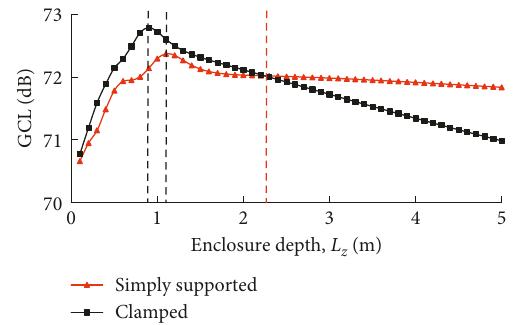
Figure 4: Effect of enclosure depth on the global coupling level of the panel-enclosure coupled system with different panel boundary